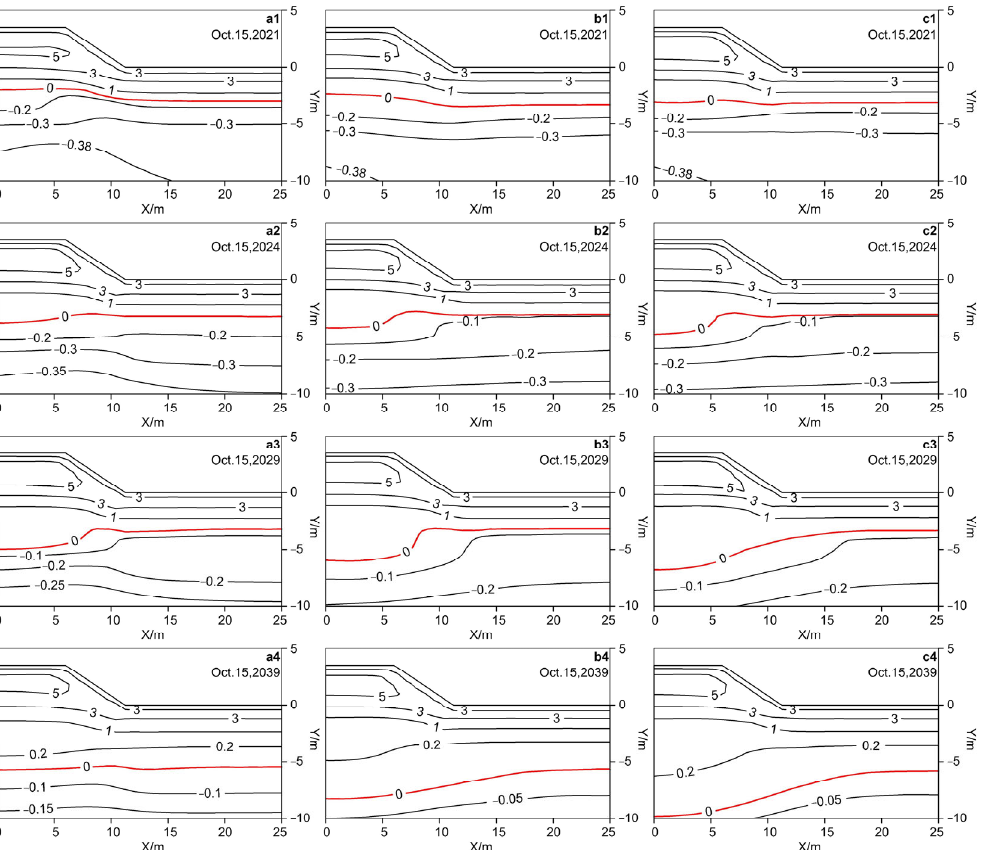
Figure 8. Temperature contour maps on October 15 of the three subgrade structures in different years: ( a1 – a4 ) replacement block–stone subgrade structure, ( b1 – b4 ) replacement breccia subgrade structure, and ( c1 – c4 ) replacement gravel subgrade structure. The 0 ℃ isotherm represents the location of the permafrost table. (Unit: ℃ ).